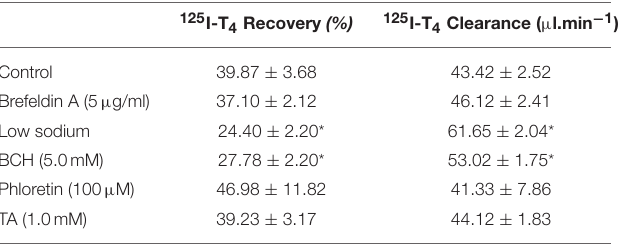
TABLE 1 | Recovery and clearance of 125 I-T 4 from the aCSF in rabbits, in the presence of various drug treatments.